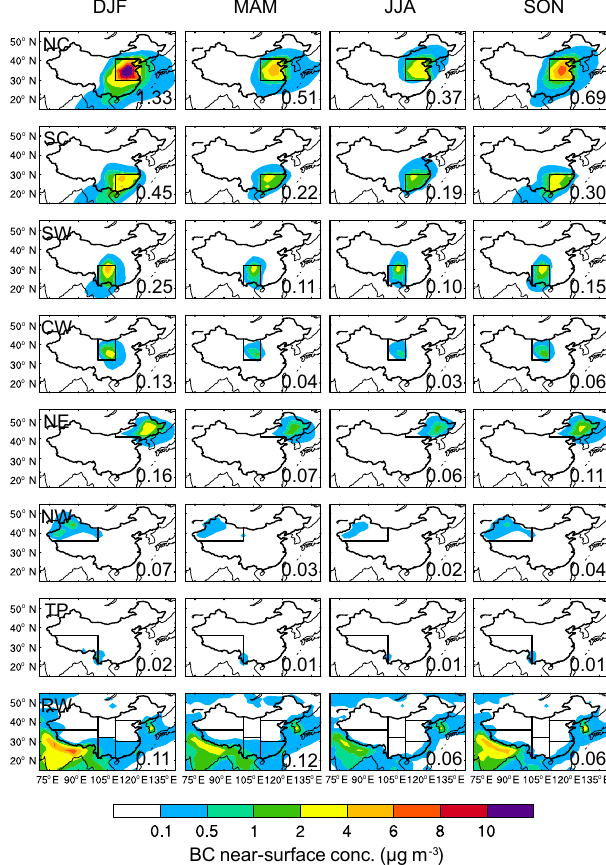
Figure 5. Spatial distribution of seasonal mean near-surface con- centrations of BC (µgm − 3 ) originating from the seven source re- gions in China (NC, SC, SW, CW, NE, NW and TP), marked with black outlines, and sources outside China (RW). Regionally aver- aged BC in China contributed by individual source regions is shown at the bottom right of each